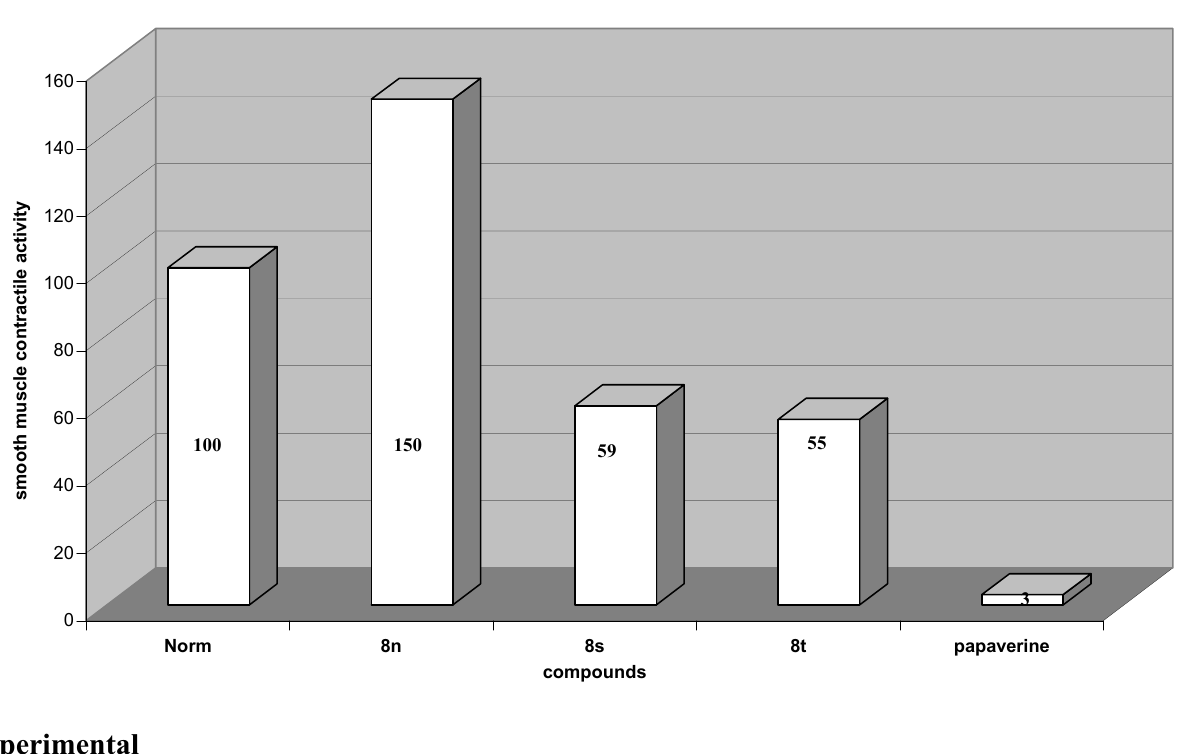
Figure 3. Change of spontaneous contractile activity of gastric smooth muscles preparation after using styrenes and papaverine, normal activity is taken for